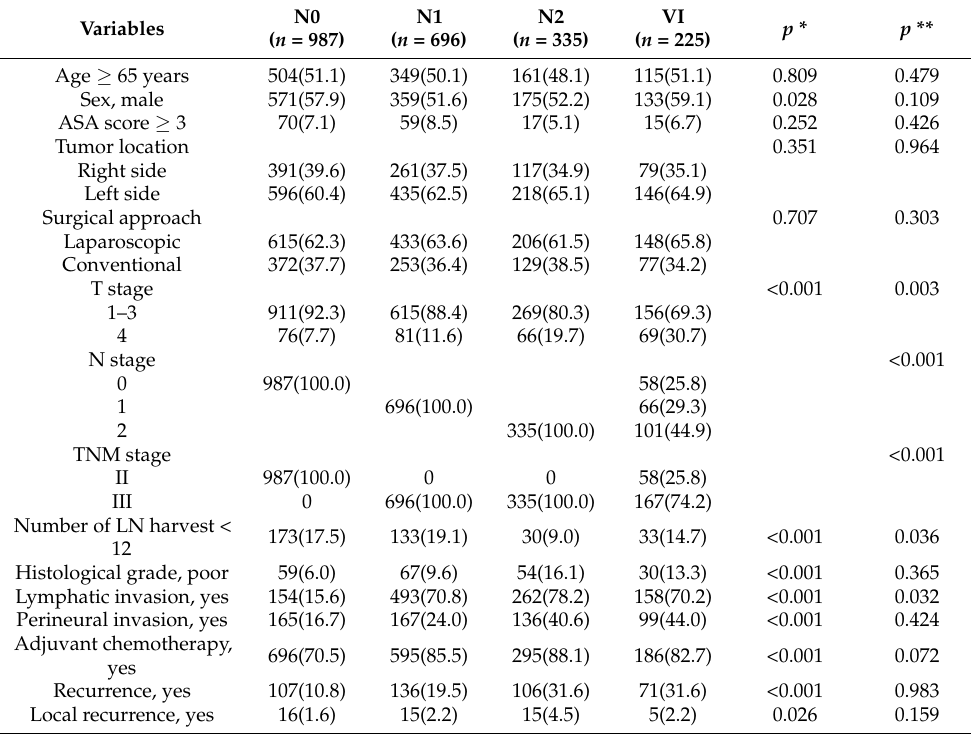
Table 2. Patient’s clinicopathological characteristics according to the study